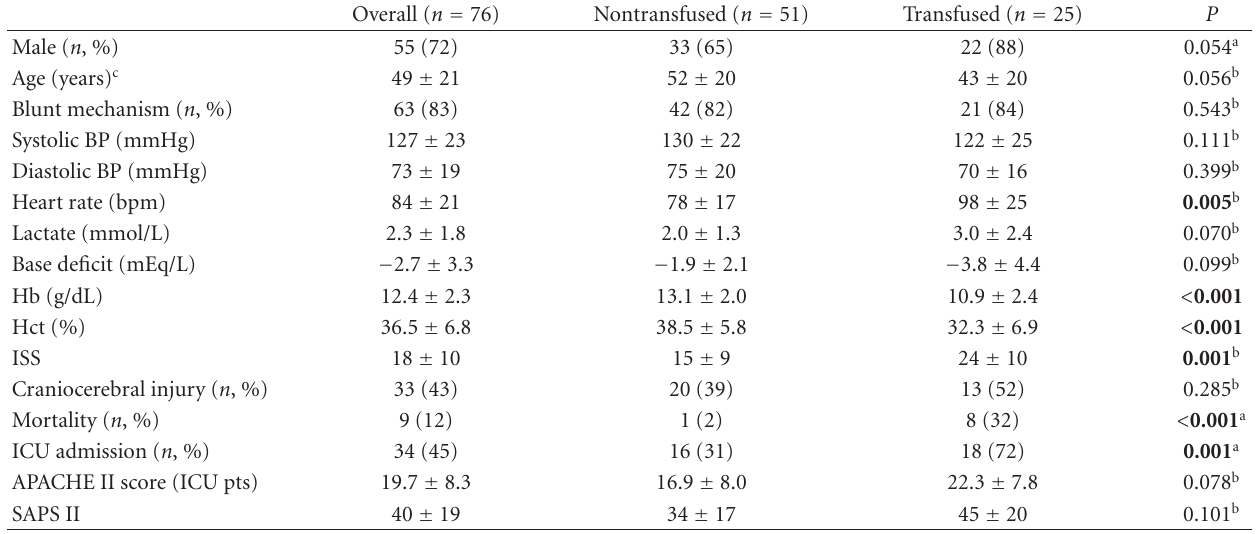
Table 1: Characteristics of overall study population, nontransfused and transfused patients. Overall ( n = 76)